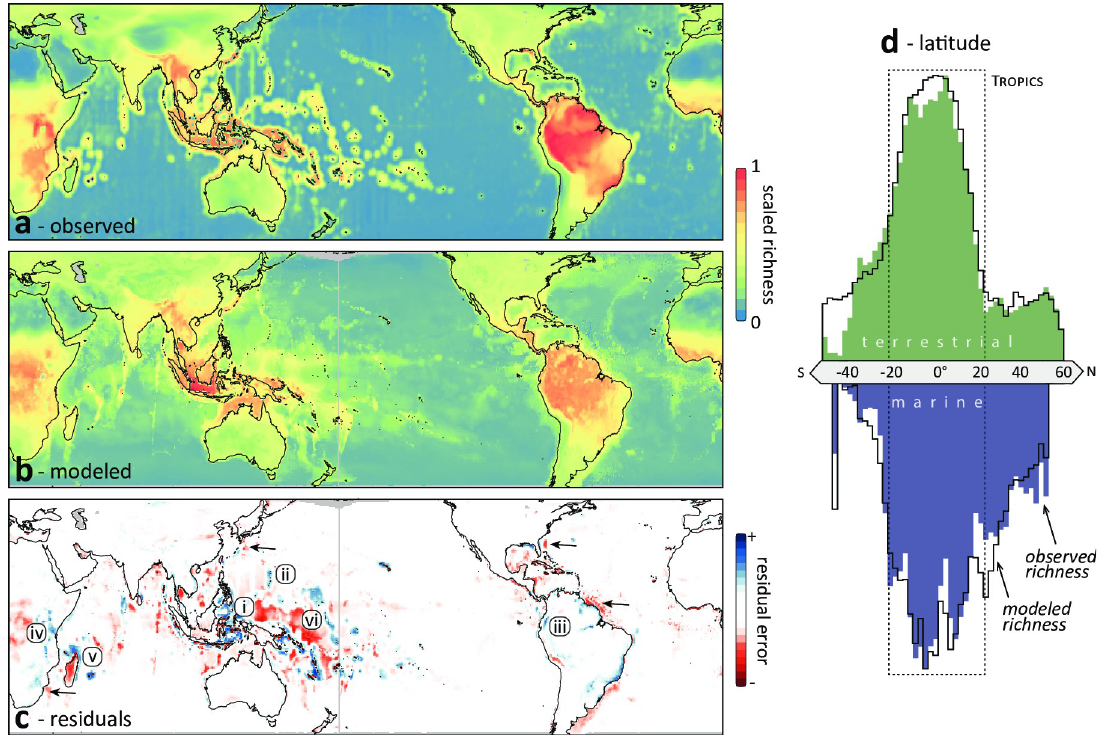
Fig 1. Global terrestrial and marine biodiversity patterns. (a) Observed species richness derived from the distributions of 44,575 marine and 22,830 terrestrial species. Species richness is ln -transformed and rescaled within each domain (terrestrial and marine) and plotted on a 50 km equal area grid. (b) Artificial neural network model predictions (ANNs) of species richness considering a suite of 29 environmental drivers. (c) Model residuals highlight areas that are particularly species-rich (underpredicted, blue) and species-poor (overpredicted, red) regions relative to the underlying environmental drivers. These highlight locations of exceptional biodiversity such as reef ecosystems of the (i) Coral Triangle and (ii) Marianas Archipelago and wet forests of the (iii) tropical Andes and (iv) Eastern Arc mountains. It also identifies species-poor settings like isolated islands (v, Madagascar) and major biogeographic boundaries in the ocean (vi, Andesite line). Arrows designate species-poor marine regions with high velocity boundary currents. (d) Latitude does not affect model performance, as there are no systematic meridional differences between observed and modelled richness. The northern- hemisphere bias of land, and the corresponding abundance of shallow ocean environments, generates a similar imbalance of marine species richness. Chart area represents the average species richness, zonally, in 2˚ latitude